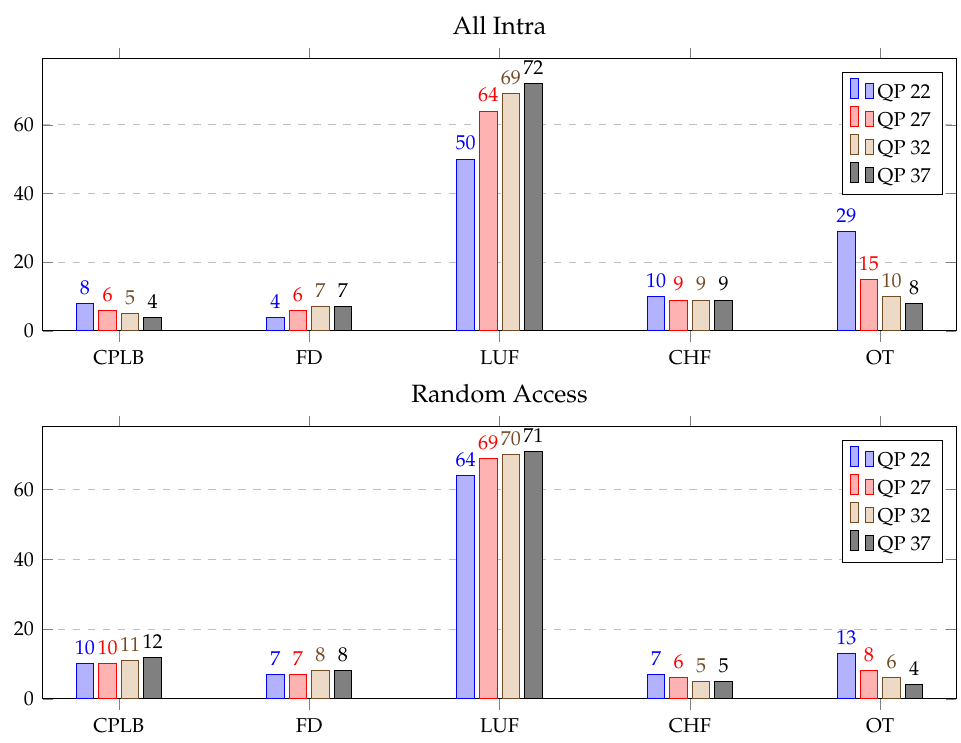
Figure 9. Average time distribution for different parts of the deblocking filter (in %) over the HGPP.